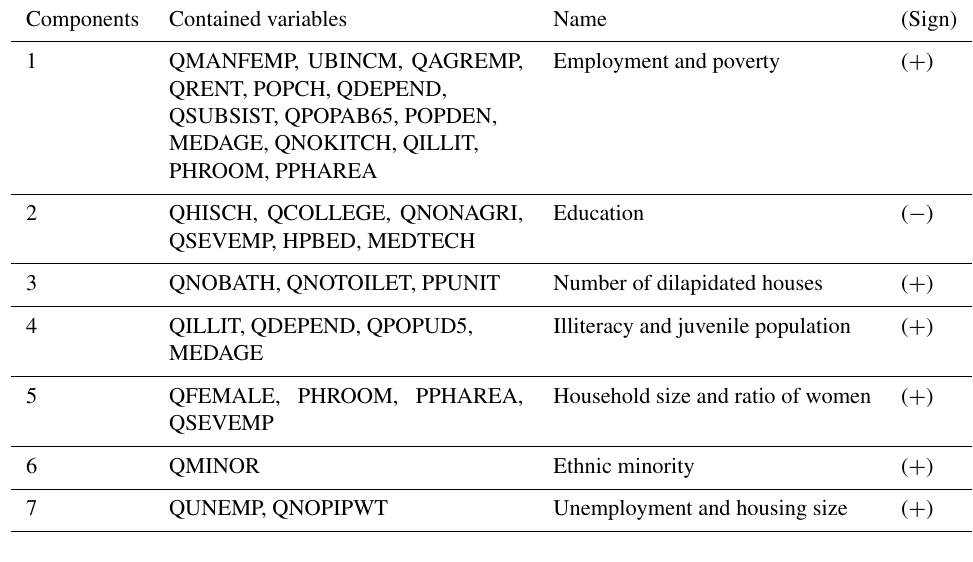
Table 4. Disaster risk index and grading.